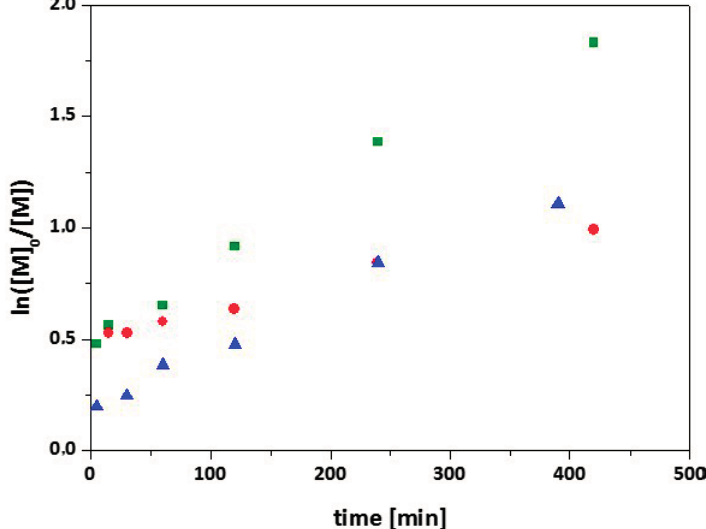
Figure 2. Kinetic plots for the polymerization of NIPAAm in DMSO at 20 °C using 7-Cl- β -CD ( ● ), 14-Cl- β -CD ( ■ ), 21-Cl- β -CD ( ▲ ) as initiators. The polymerizations